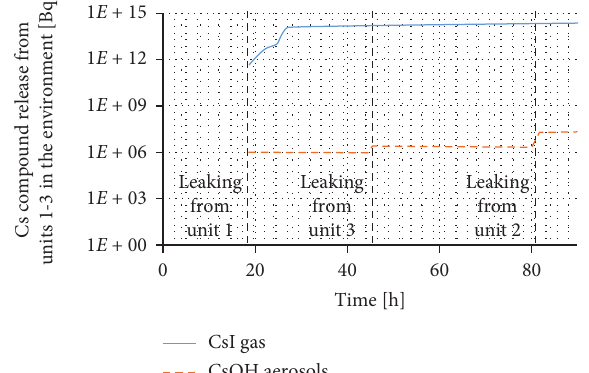
Figure 12: Total accumulative release of CsI gas and CsOH aerosols from Units 1–3 of the first case simulated by Modified ART Mod